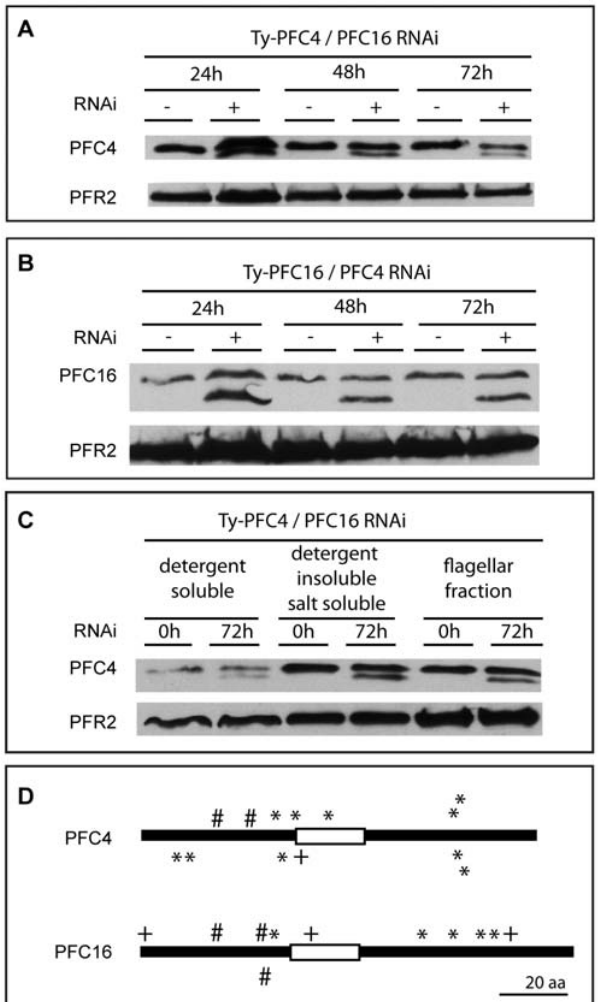
Figure 3. Analysis of PFC4 and PFC16 after induction of RNAi. A. Ty-PFC4 after RNAi ablation of PFC16. B. Ty-PFC16 after RNAi ablation of PFC4. In both cases a second band with higher mobility in the gel appears as soon as 24 hours after RNAi induction. C. Western blotting analysis of various cell fractions showing Ty-PFC4 after RNAi ablation of PFC16. Both bands are present in all cell fractions. Ty epitope tagged PFR proteins were detected using BB2 antibody. Loading control was performed using L8C4. D. Cartoon representation of predicted post- translational modification sites and conserved motifs for both PFC4 and